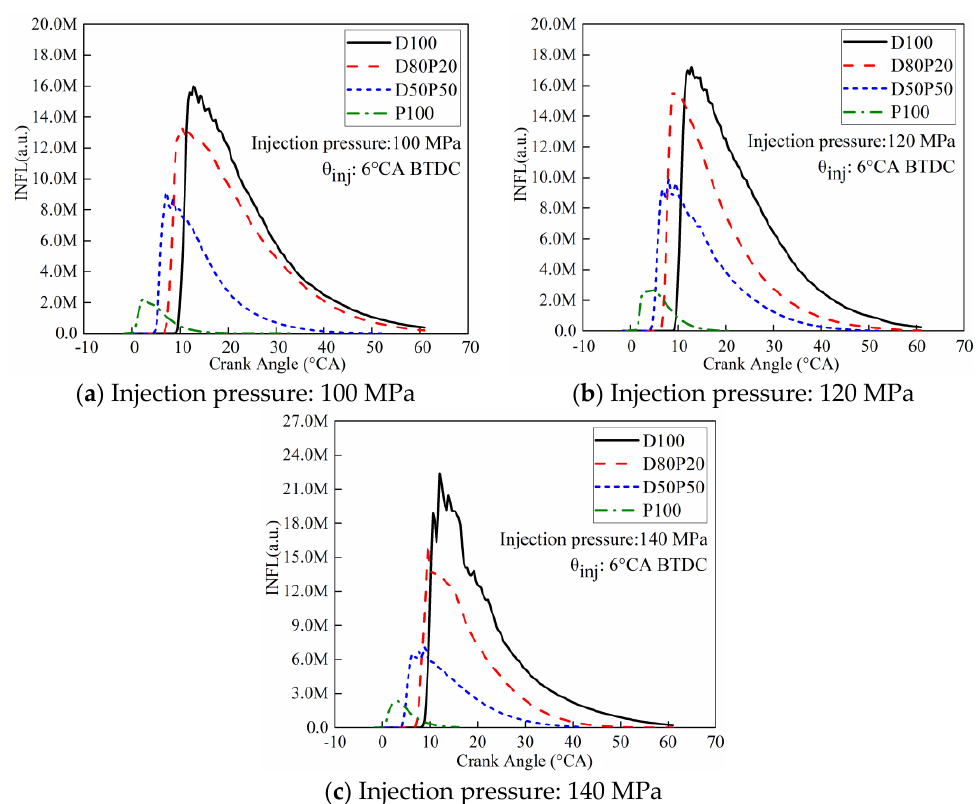
Figure 13. Integrated natural flame luminosity (Injection timing: 6 °CA BTDC).